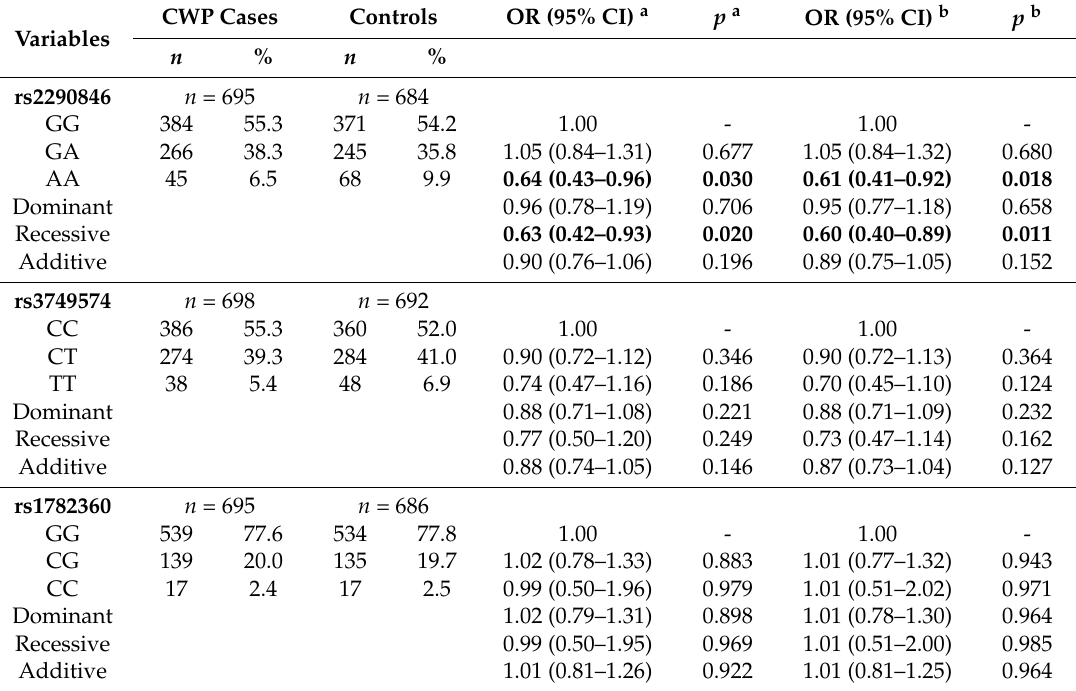
Table 3. Distributions of genotypes of LRBA and their associations with CWP